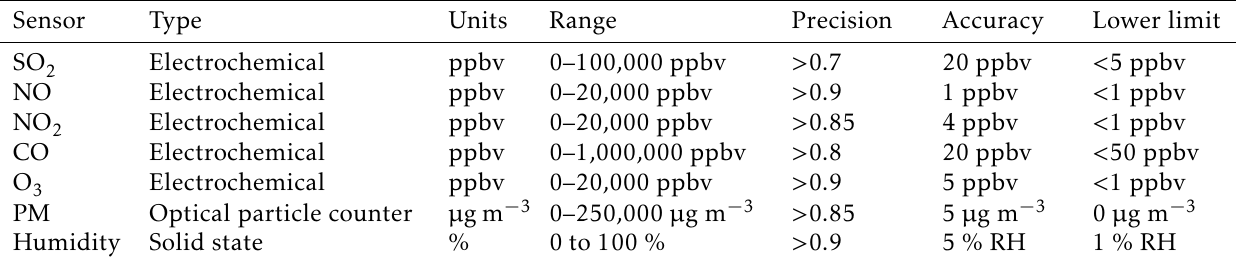
Table 1: AQMesh pod sensor specifications for Nicaragua installation. Instrument specifications as stated by AQMesh